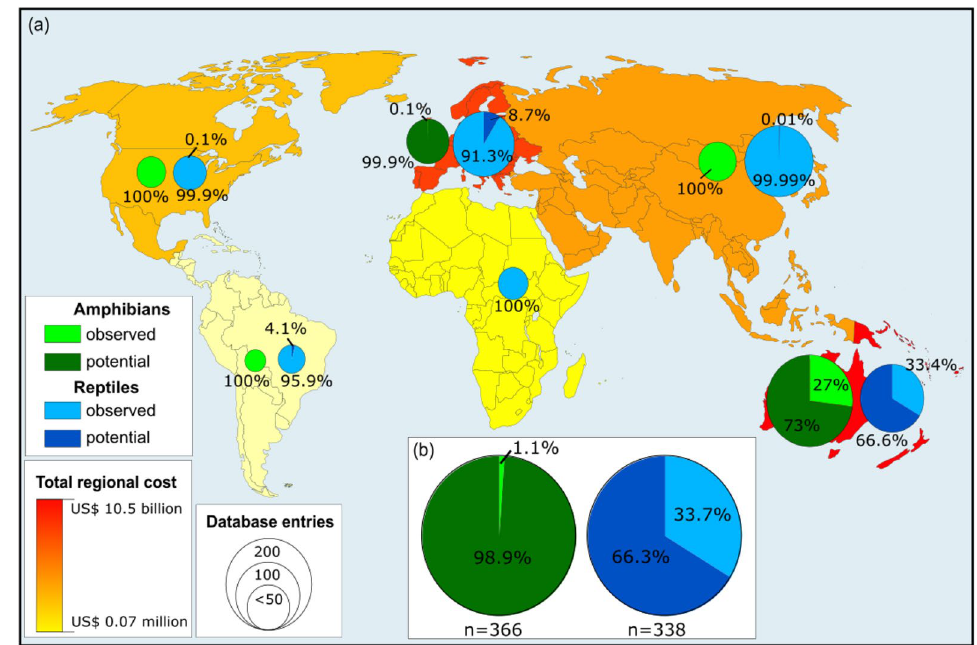
Figure 4. Geographical distribution of the economic costs of alien species, with the total regional cost of alien amphibians and reptiles (colour ramp), divided by Implementation ( Observed vs. Potential ) and scaled in size by the number of entries ( a ); and the total global cost divided by Implementation ( b ). Note that Africa has no recorded economic costs of alien